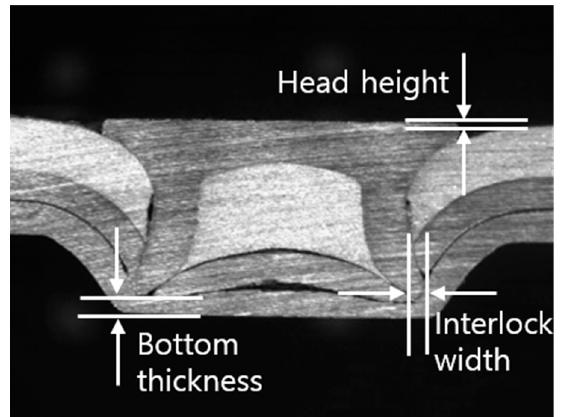
Figure 4. Definition of geometrical indices of the SPR joint.